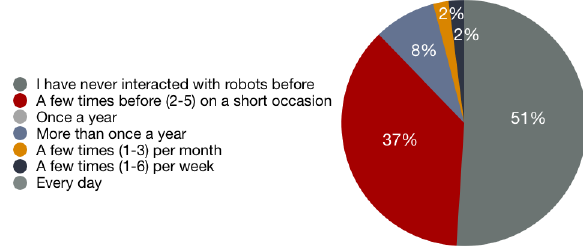
Figure 23: Number of times participants experienced interacting with robots before the experiment.